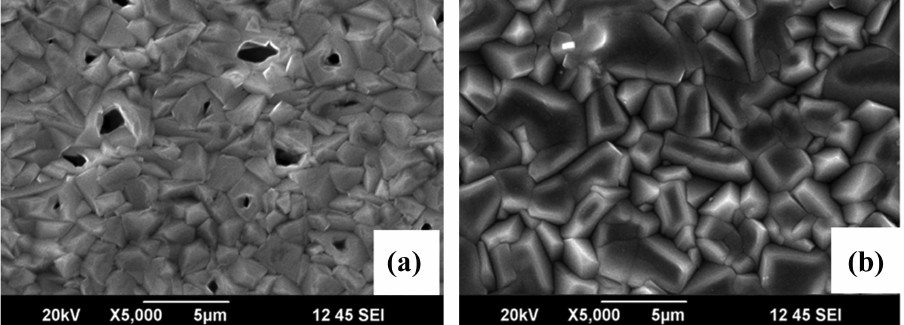
Figure 4: Surface scale morphologies of the oxide formed on Ferritic Steel T22 exposure to SCW for 1000 h. (a) 540°C, (b)